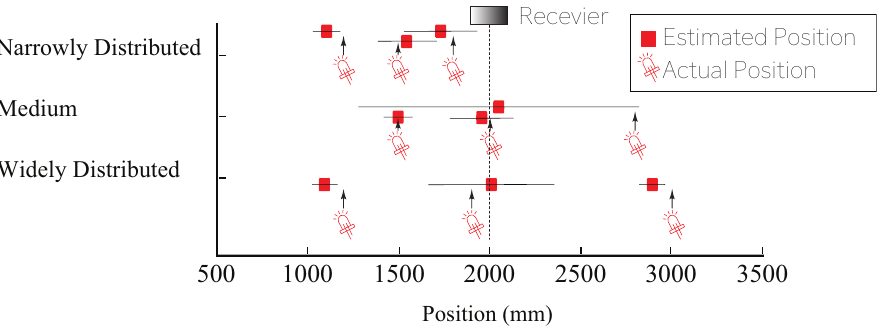
Figure 6. Comparison of positioning performance using multiple beacons (beacons were arranged at 1200, 1900, and 3000 mm distances for a widely distributed configuration, 1500, 2000, and 2800 mm for the medium condition, and 1200, 1500, and 1800 mm for a narrowly distributed configuration,